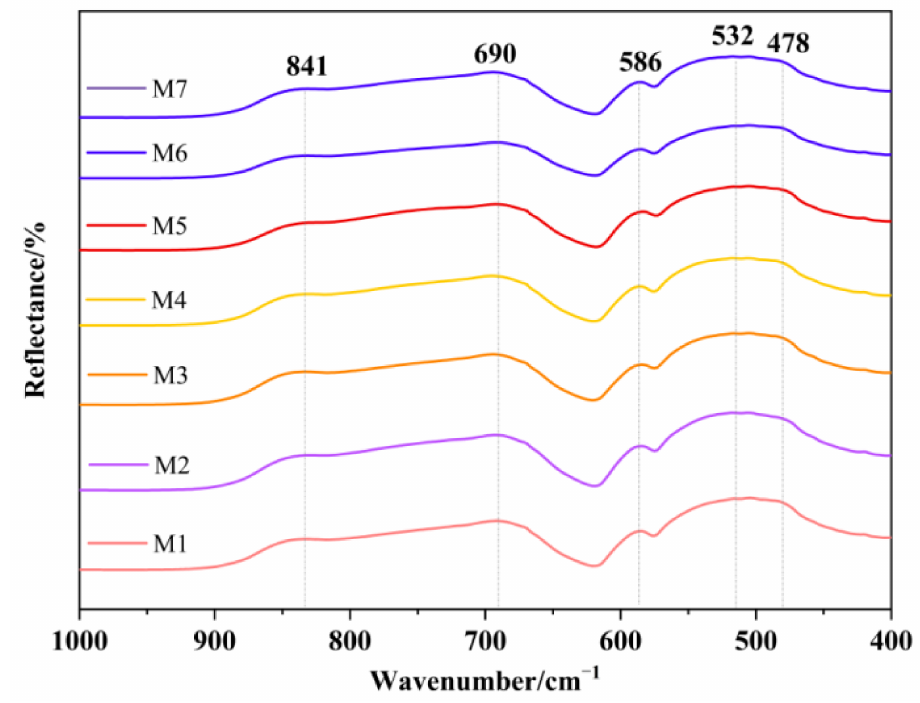
Figure 4. FTIR spectra of different colored spinels from